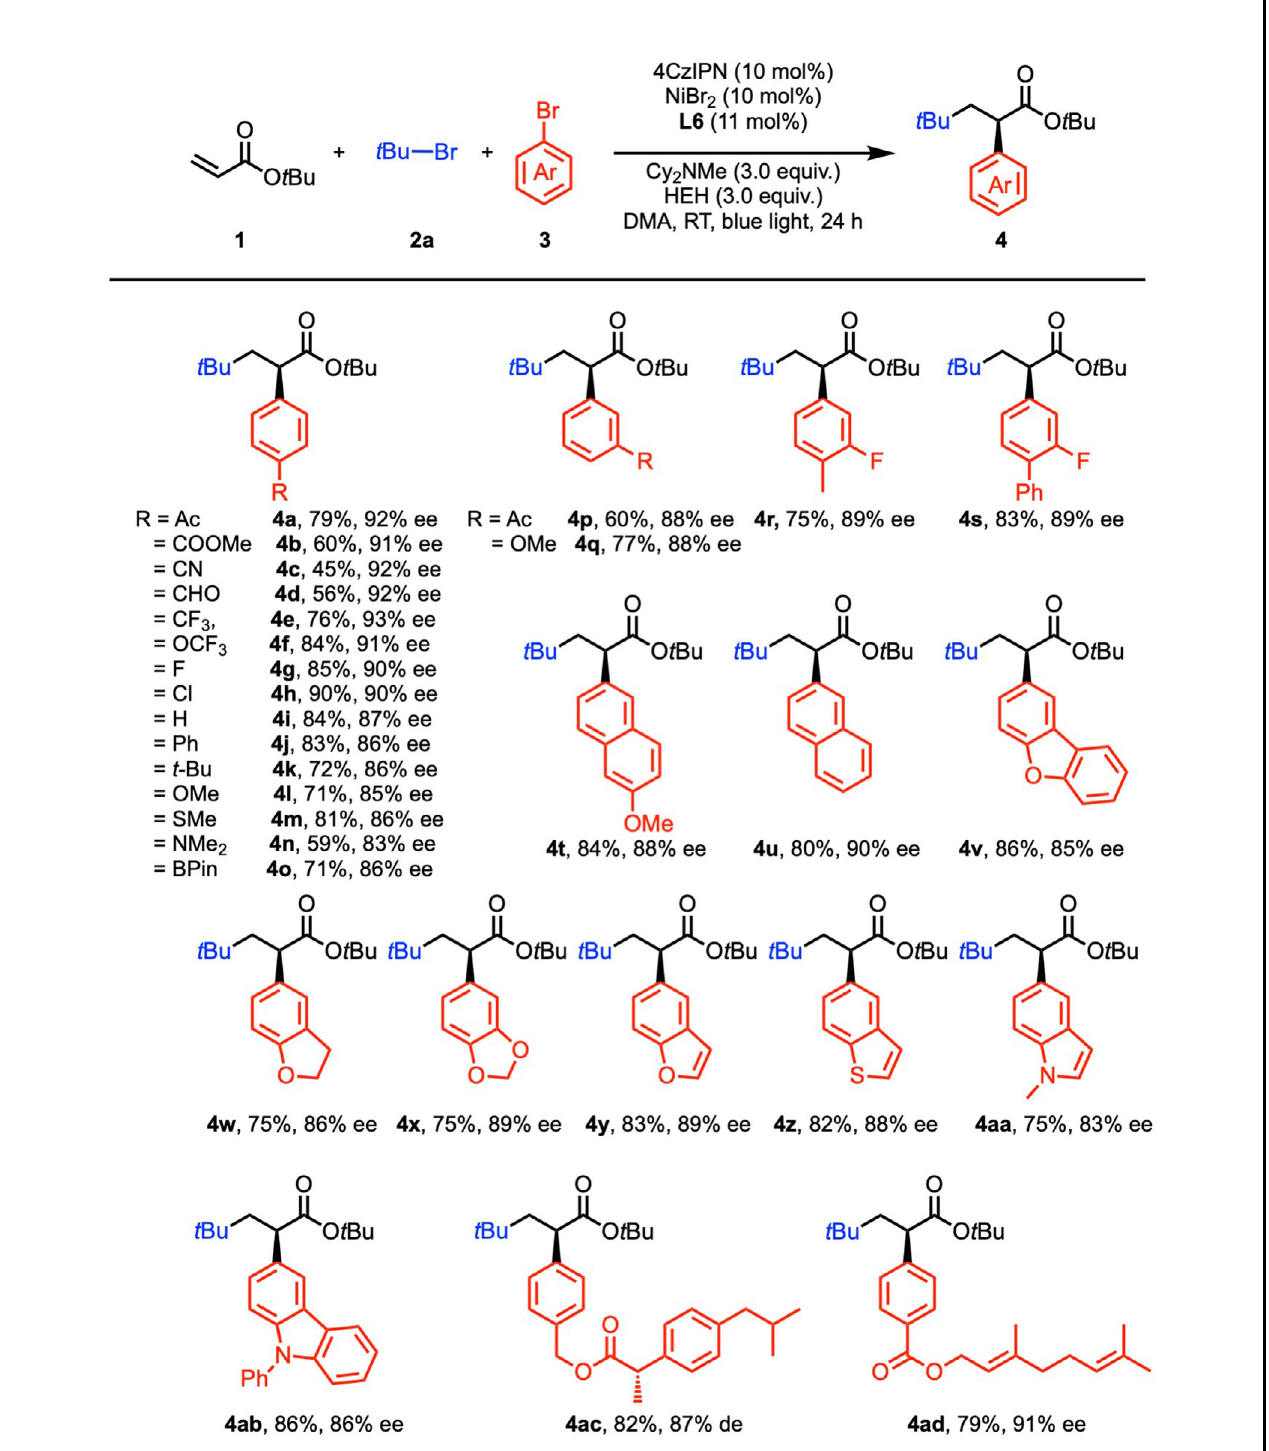
Table 2 Scope of aryl and (hetero)aryl bromides. [a]